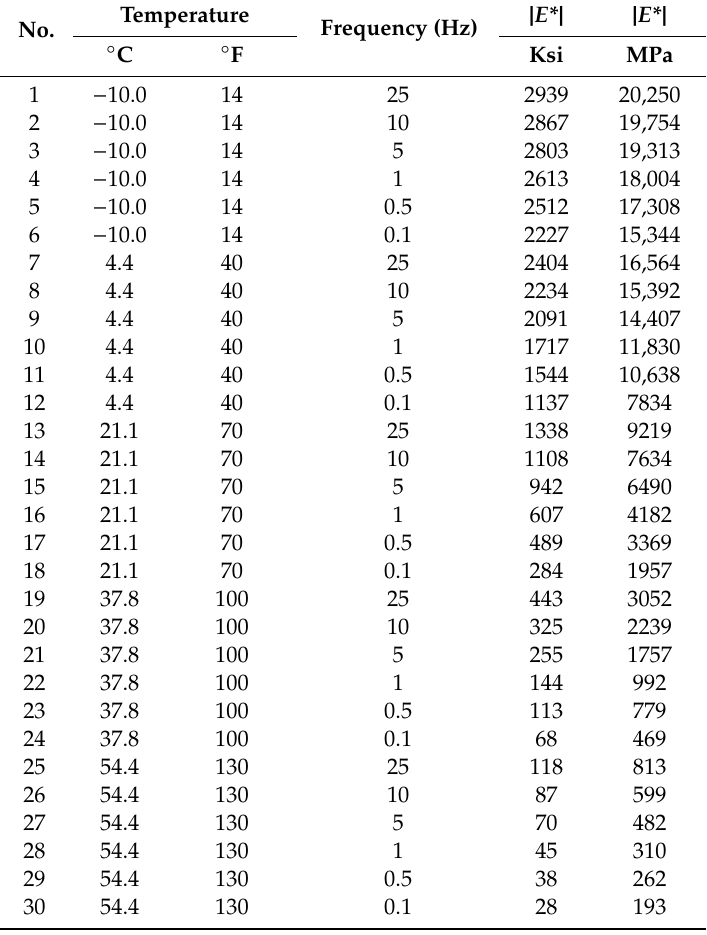
Table 3. Fitted dynamic modulus of S (100) PG 64-22